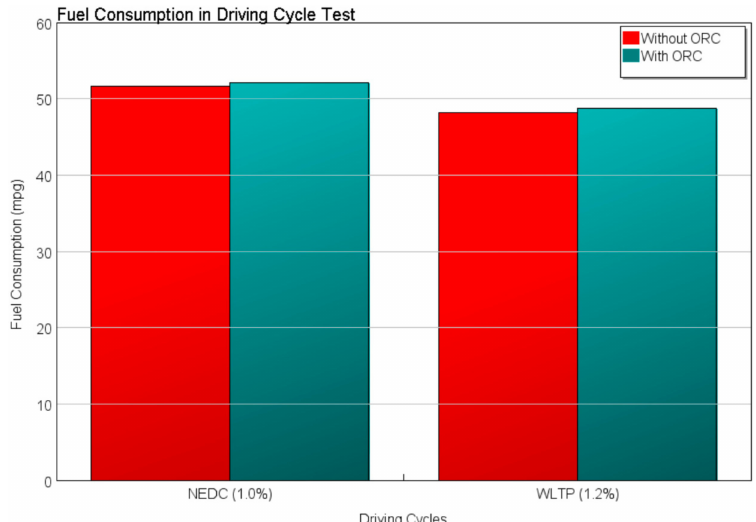
Figure 32. Comparison of Fuel Consumption per Driving Cycle with and Without